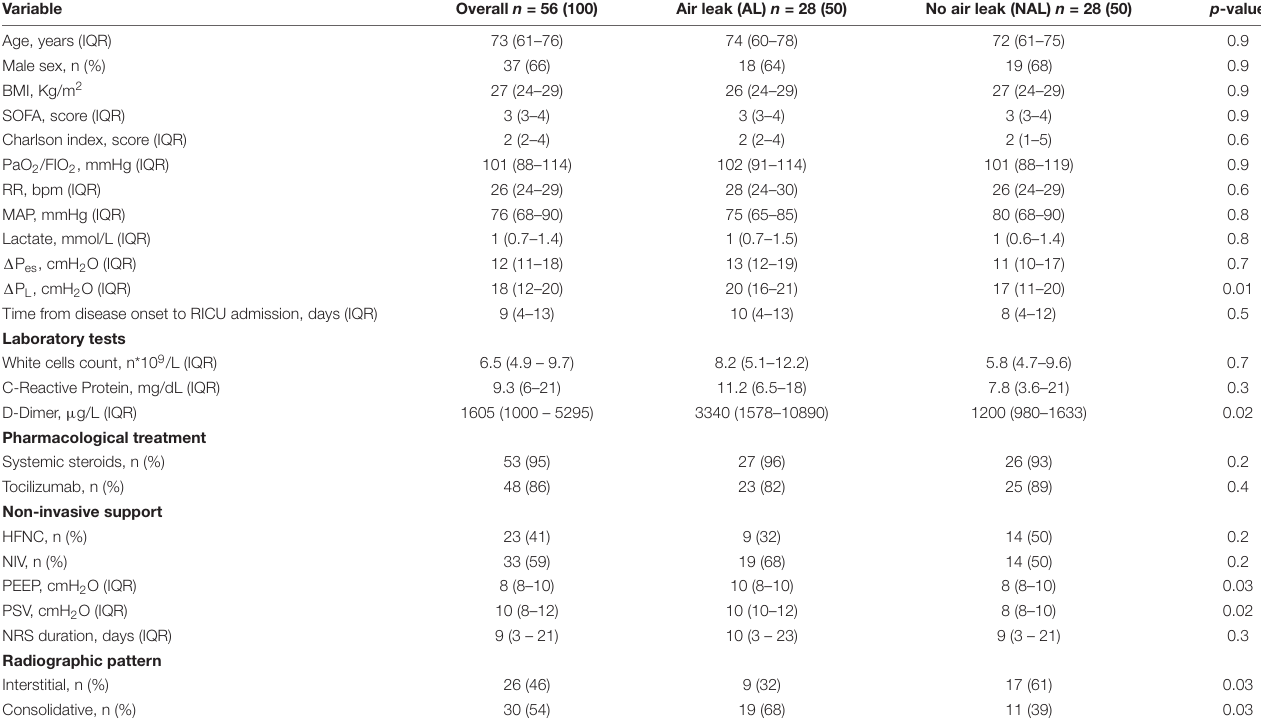
TABLE 1 | General and clinical features of the study population presented as a whole and according to the onset of air